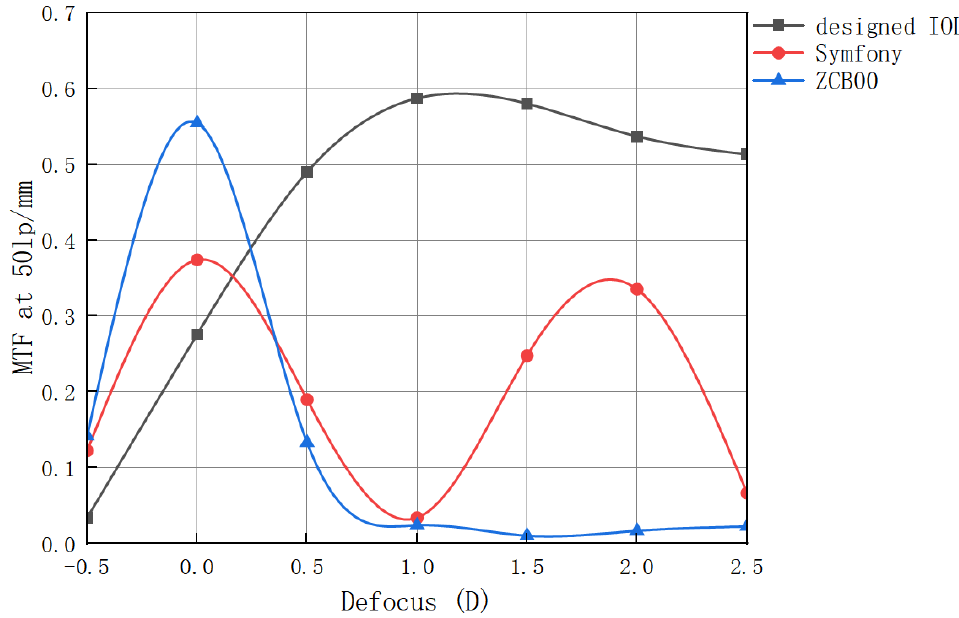
Figure 7. Through-focus MTF at 50 lp/mm at a 0° field in polychromatic light for the designed IOL and two commercial IOLs: Symfony and ZCB00 under 3 mm pupil.